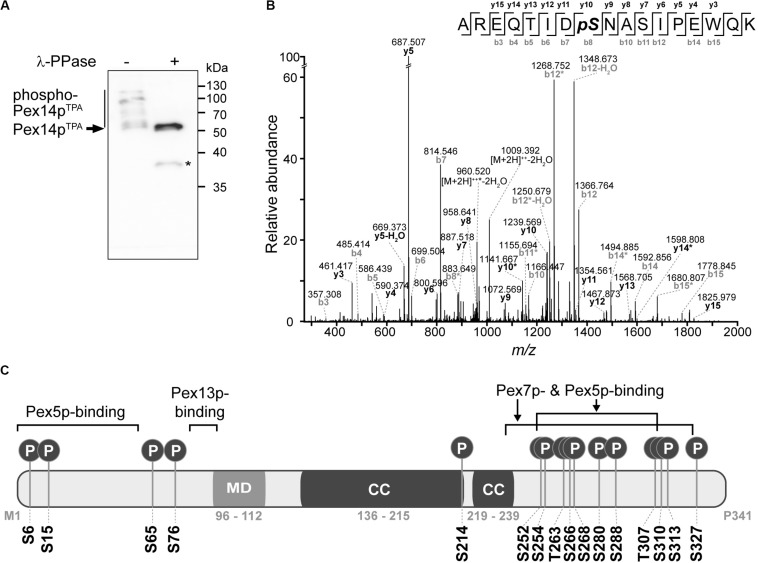
Pex14p is multiply phosphorylated in vivo. (A) TPA-tagged Pex14p (Pex14pTPA) expressed from its native chromosomal location was affinity-purified from a Triton X-100-solubilized crude membrane fraction of yeast cells grown in oleic acid-containing medium. Affinity chromatography was performed using IgG-coupled Sepharose and proteins were eluted with glycine (pH 2.4). Proteins from phosphatase (λ-PPase)-treated (+) and untreated (-) samples were analyzed by Phos-tag SDS-PAGE and immunoblotting using anti-Pex14p antibodies. Note that also non-phosphorylated proteins generally migrate slower in Phos-tag gels compared to normal SDS gels (Kinoshita et al., 2009). *Pex14p degradation band. (B) Representative MS/MS spectrum showing phosphorylation of Pex14p at S310 (AREQTIDpSNASIPEWQK; m/z 1027.474; z = +2). *fragment ion with neutral loss of H3PO4. (C) Schematic representation of Pex14p showing the localization of in vivo phosphorylation sites. Phosphorylation at S6, S15, S76, T263, and S327 are reported here for the first time. MD, predicted membrane domain (according to Azevedo and Schliebs, 2006). Pex5p-, Pex7p-, and Pex13p-binding regions are depicted according to Azevedo and Schliebs (2006). Please note that alternative Pex14p-Pex13p binding sites have been proposed (Schell-Steven et al., 2005). While a second Pex14p interaction site has been mapped for Pex13p (Schell-Steven et al., 2005; Williams and Distel, 2006), an additional Pex13p binding site in Pex14p has not yet been reported. Coiled-coil (CC) domains were predicted using PredictProtein (Rost et al., 2004).